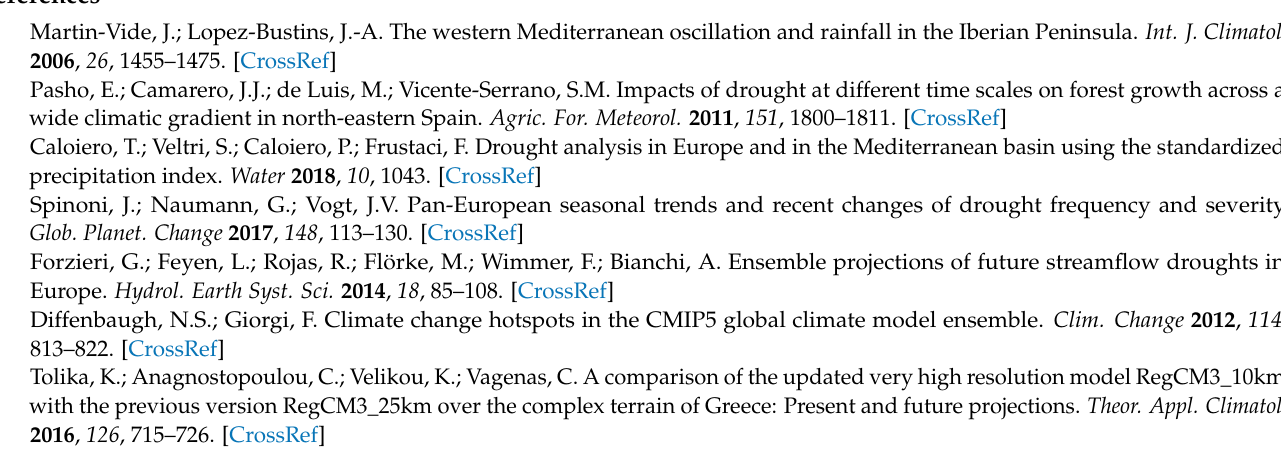
Figure S6: Intensity behavior as a function of mean annual temperature and annual precipitation, Figure S7: Duration behavior as a function of mean annual temperature and annual